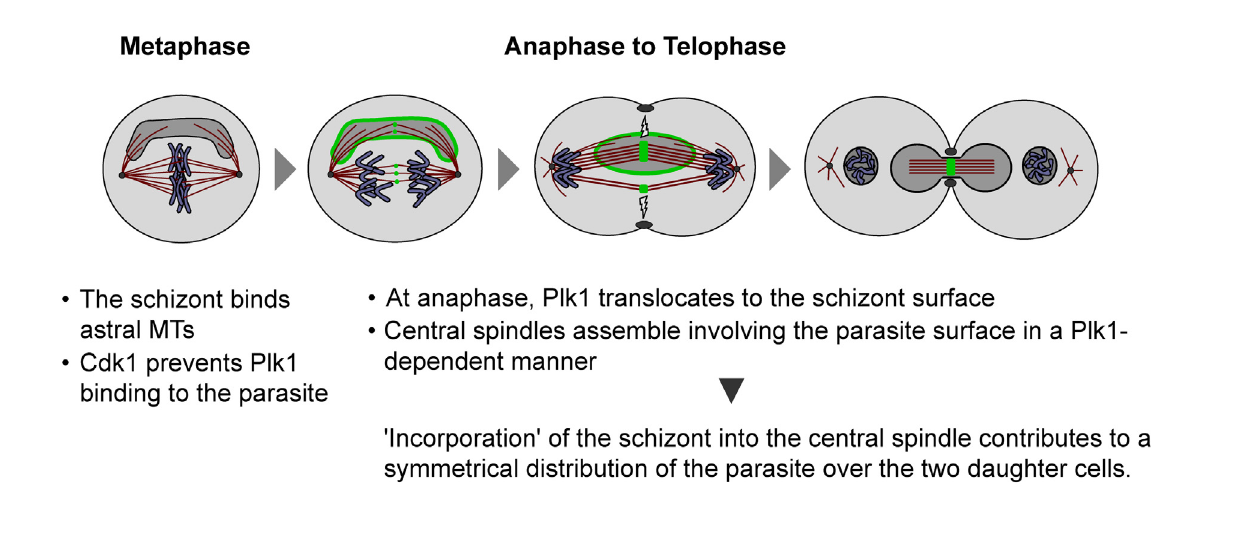
Figure 11. Schematic presentation of parasite interactions with astral and central spindle MTs during host M phase. Green depicts Plk1 binding to the parasite and central spindles.